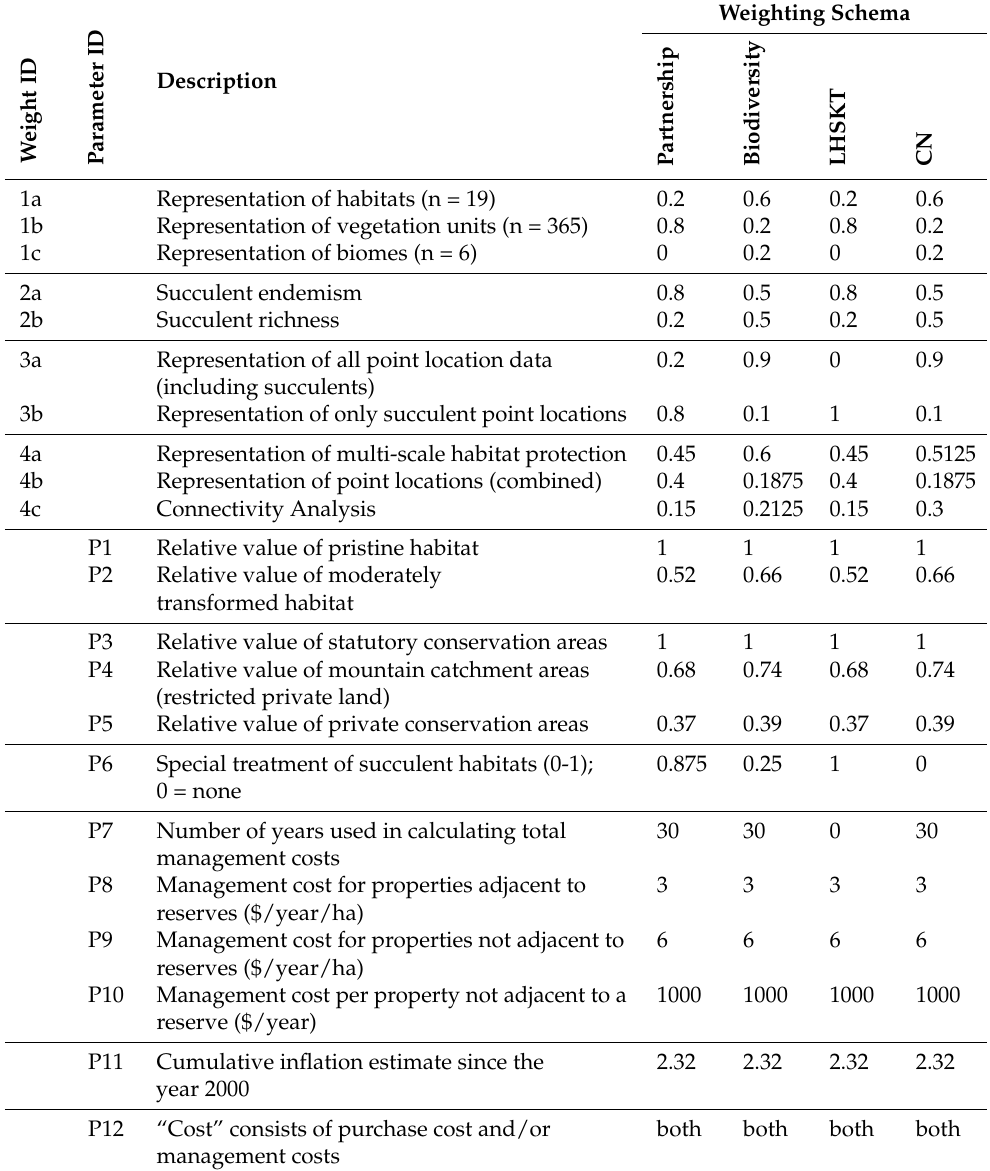
Table 1. The weight and parameter values for the four weighting schemas. Prices have been converted from Rand to Dollars at the rate at the time of 7.5:1. (Table cross-references with Figure 2 and Table